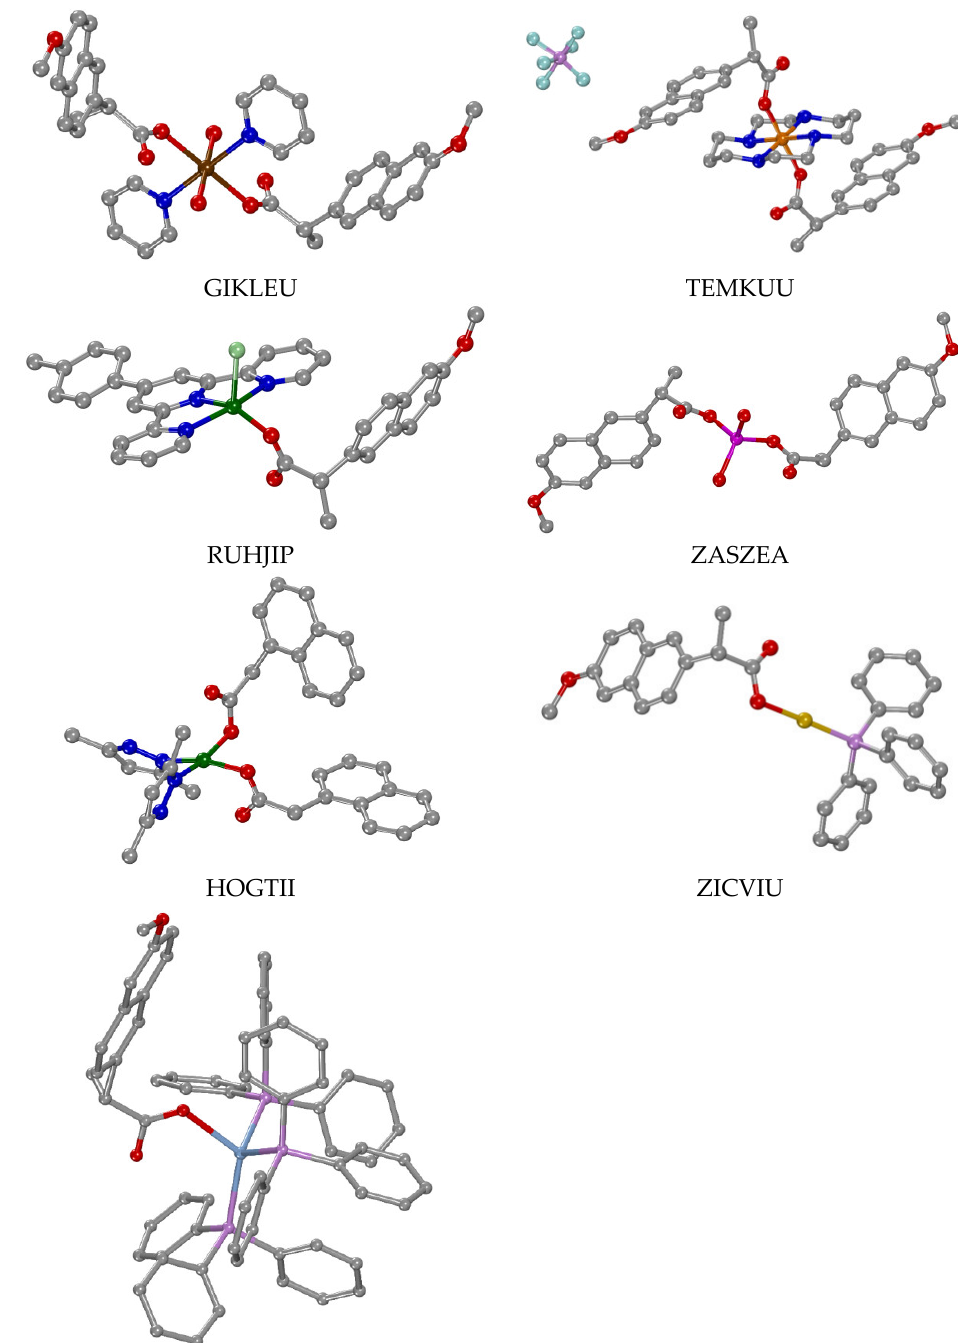
Figure 15. Molecular structures of selected complexes bearing monodentate ligands. GIKLEU = [Mn(NAP–O) 2 (py) 2 (H 2 O) 2 ] [42], TEMKUU = [Co(NAP–O) 2 (cyclam)] [44], RUHJIP = [Cu(NAP–O)(L1)Cl] [49], ZA- SZEA = [Zn(NAP–O) 2 (H 2 O) 2 ] · H 2 O [46], ZICVIU = [Au(NAP–O)(PPh 3 )] [51], HOGTII = [Cu(N1A– disordered atoms and solvate molecules are omitted for clarity reasons. Color code for atoms: C: gray, O: red, N: blue, Mn: brown, Co: orange, P: violet, F: light sea-blue, Cu: green, Cl: light green, Zn: magenta, Au: gold-yellow and Ag: cyan. The figures of the structures were adapted from the corresponding references.